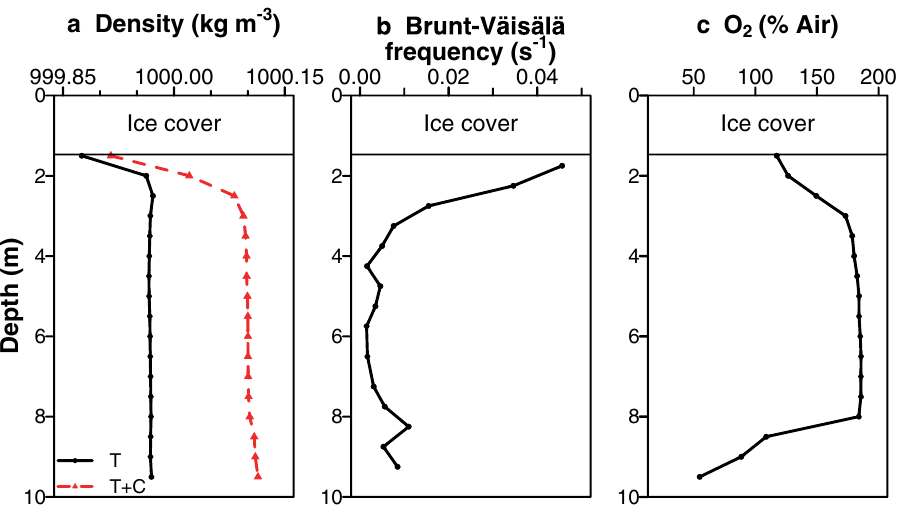
Figure 2. Physicochemical profiles in Ward Hunt Lake. ( a ) Density calculated considering temperature only (T; in black) and considering both temperature and salinity, as measured by conductivity (T + C; in red), ( b ) Brunt- Väisälä frequency and ( c ) dissolved oxygen (expressed as % of air equilibrium), 14 July 2016.